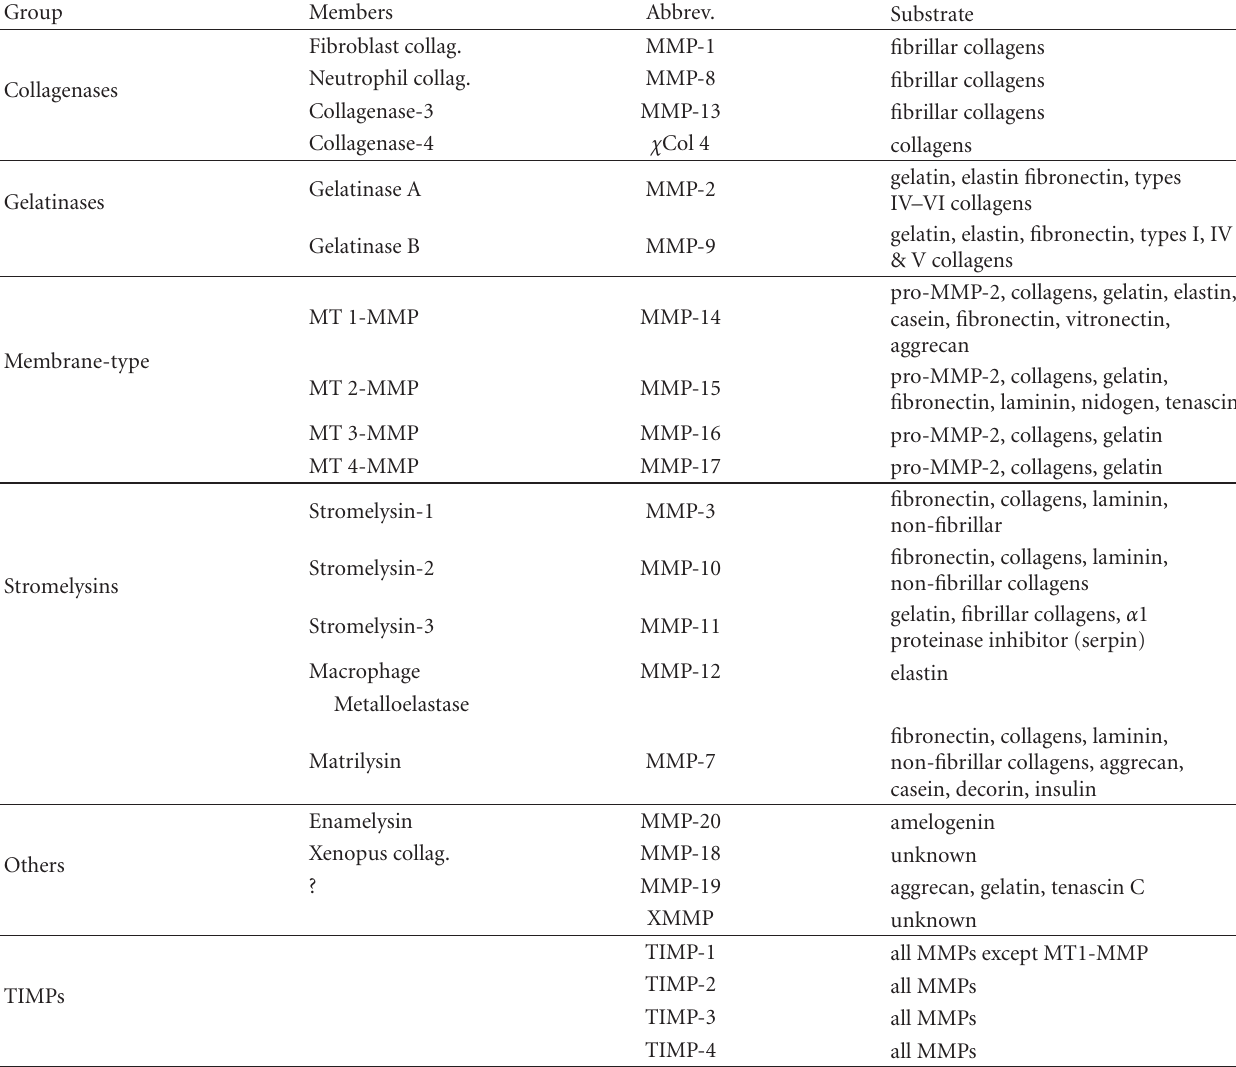
Table 1: Matrix metalloproteinases (MMPs), tissue inhibitors of metalloproteinases (TIMPs), and their preferred substrates.